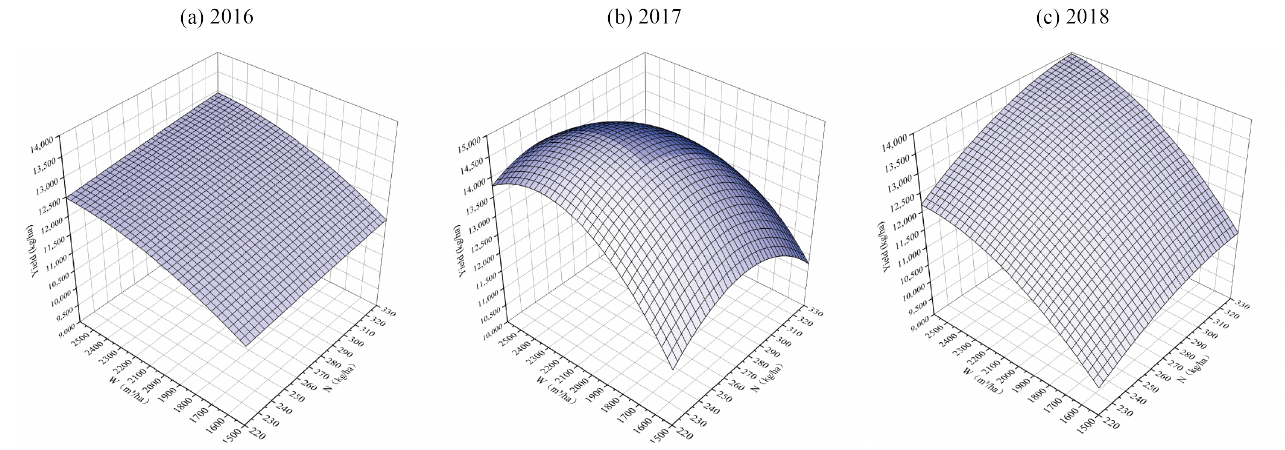
Figure 6. The effect of coupling of water and nitrogen on the yield of Maize. ( a ) 2016. ( b ) 2017. ( c )